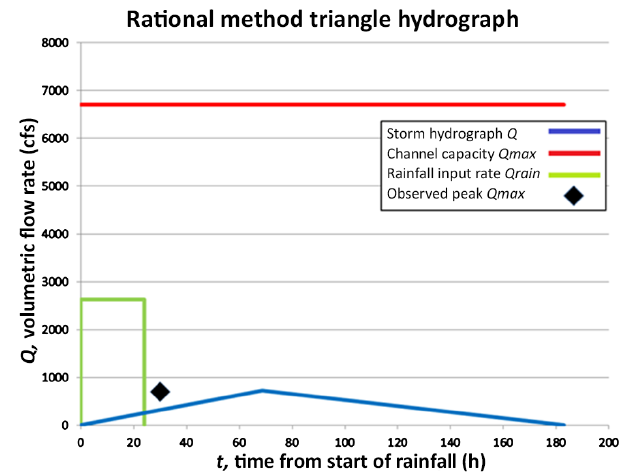
Figure 1. Illustration of the visualization produced by the DMDGC module. The rational method and a triangular synthetic unit hydro- graph are applied to model a rainstorm’s streamflow hydrograph based on a rainfall input and watershed parameters, and this is visu- ally compared with a calculated flow channel capacity to determine whether a flood will occur during a specified design storm event. The model can be calibrated such that the timing and magnitude of the observed flood peak (black diamond) matches the modeled streamflow hydrograph (blue triangle). Adapted with permission from Ruddell and Schiesser